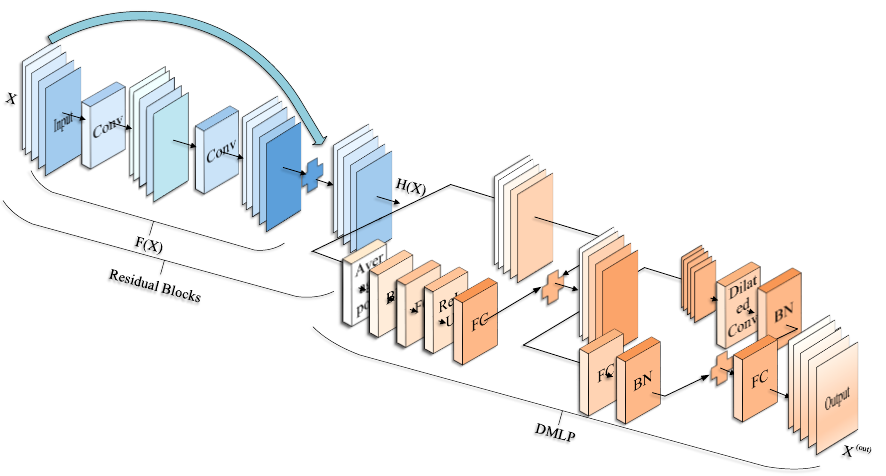
Figure 5. The structure of residual blocks with DMLP.